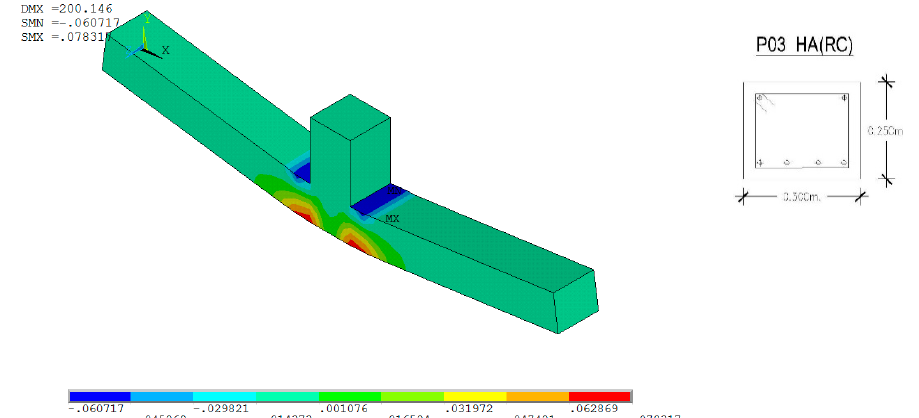
Figure 14. Plastic strain on the x -axis in the concrete, tension, and compression for a 350 mm deflection.